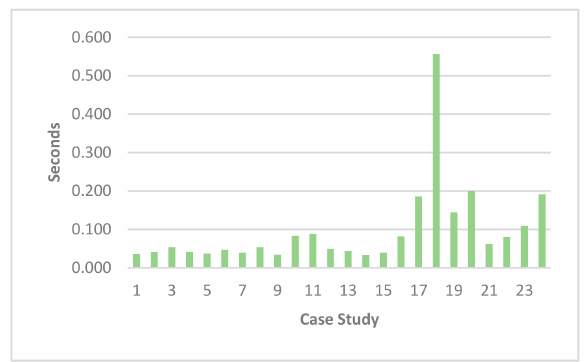
Figure 19. The results of solving time for the studied